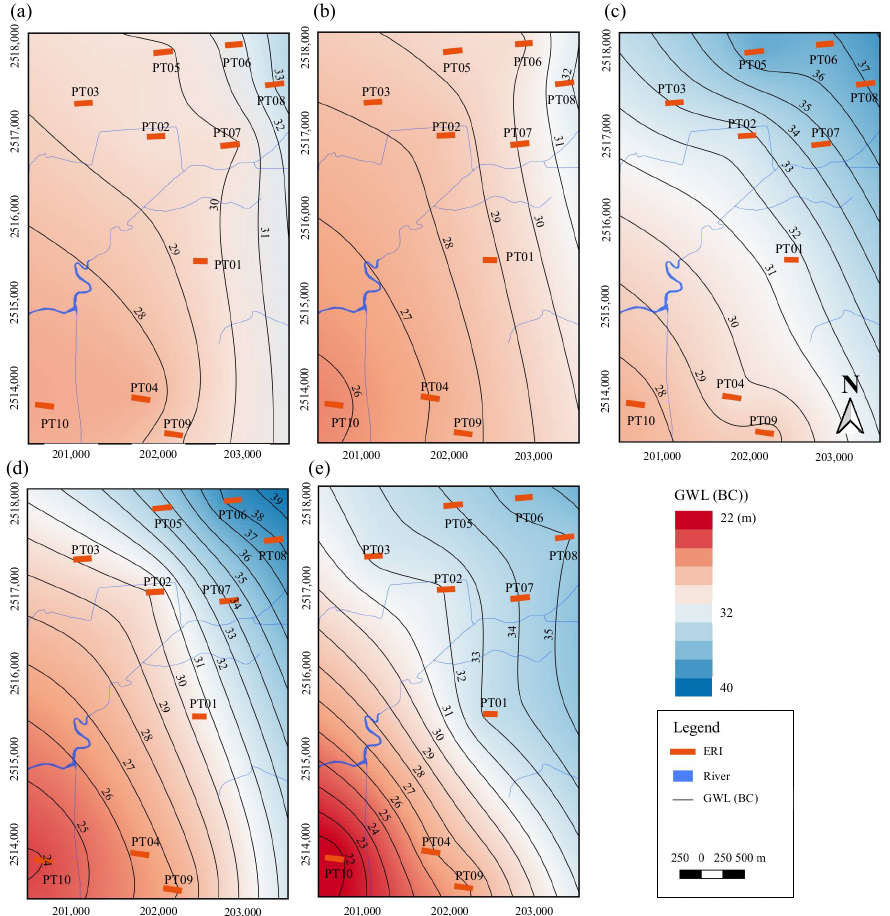
Figure 13. Spatial distribution contour map of the GWL obtained from BC for different months: ( a ) February, ( b ) April, ( c ) July, ( d ) September, and ( e ) November.